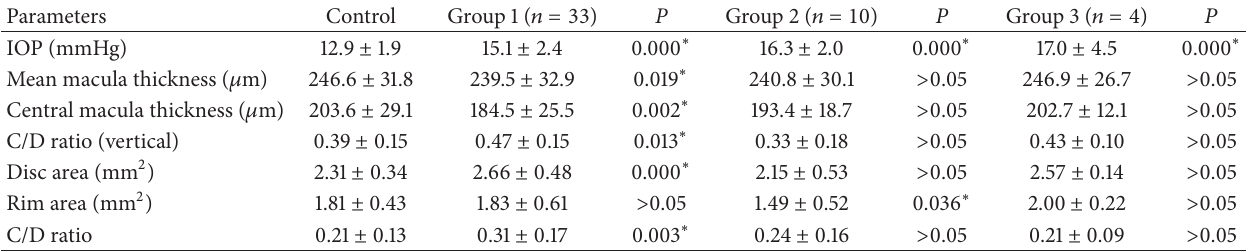
Table 3: Comparison of OCT parameters and IOP between control group and the patients with thyroid-associated ophthalmopathy based on Hertel exophthalmometer